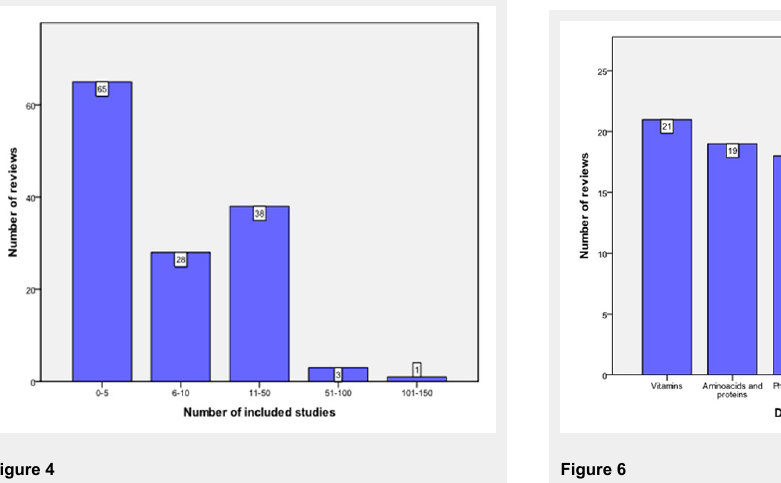
Number of studies included in Cochrane reviews.